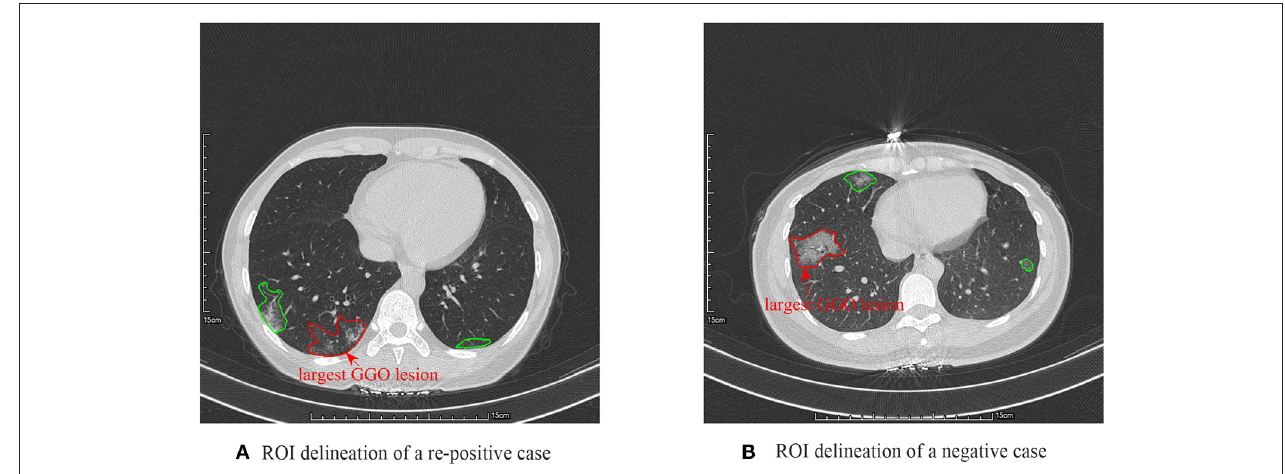
FIGURE 1 | Region of interest delineation results of a re-positive case (A) and a negative case (B) .